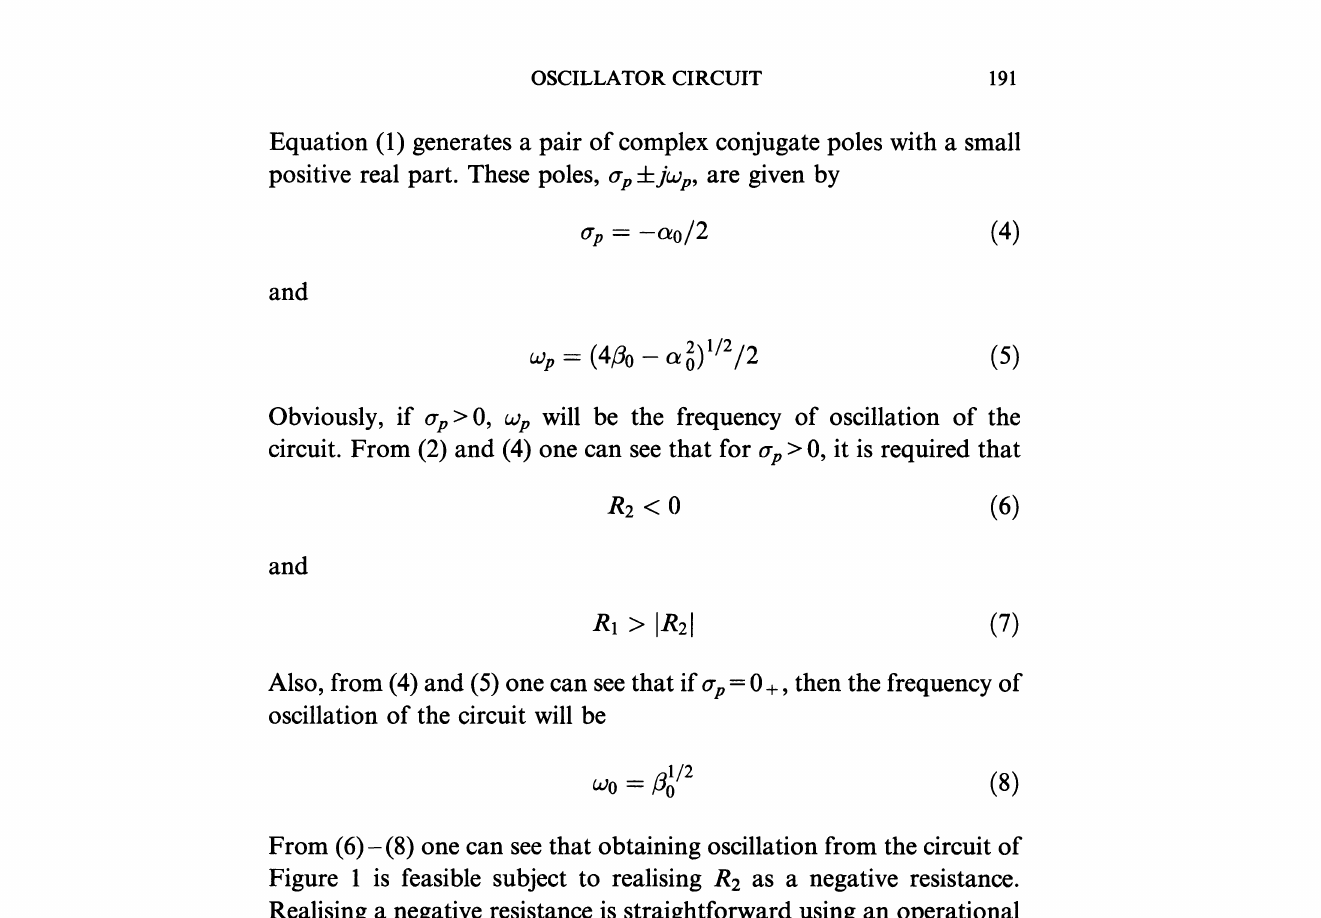
is feasible subject to realising R2 as a negative